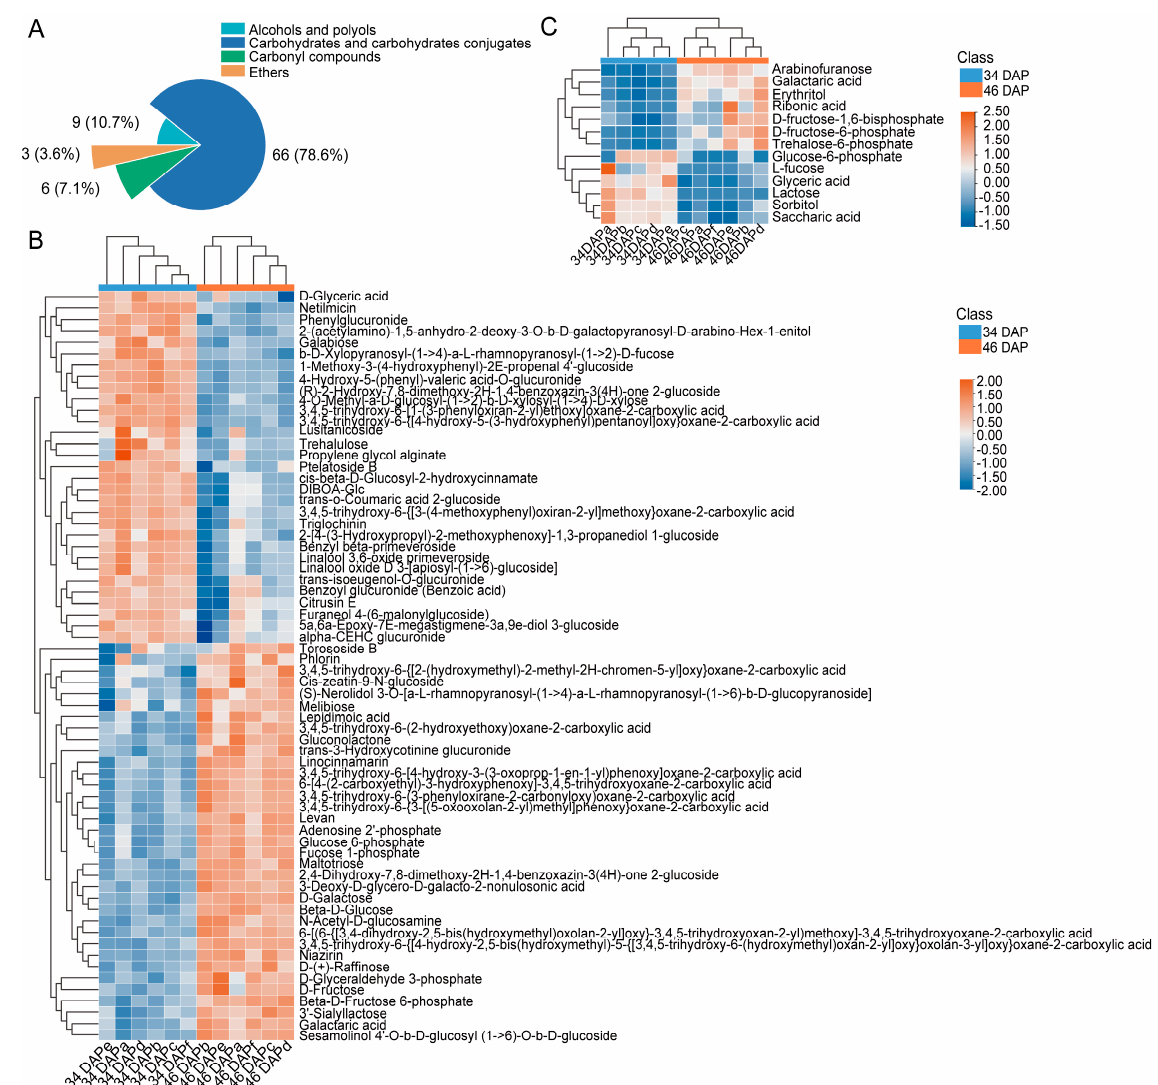
Figure 2. Classification and heatmap of DAMs in wucai leaves. ( A ) Classification of organooxygen compounds in each sub class category in LC-MS/MS. ( B , C ) Heatmap of DAMs as carbohydrates and carbohydrate conjugates in LC-MS/MS and GC-MS/MS. The data were derived from the numbers of DAMs in each sub-class category in the LC-MS/MS and GC-MS/MS analyses.